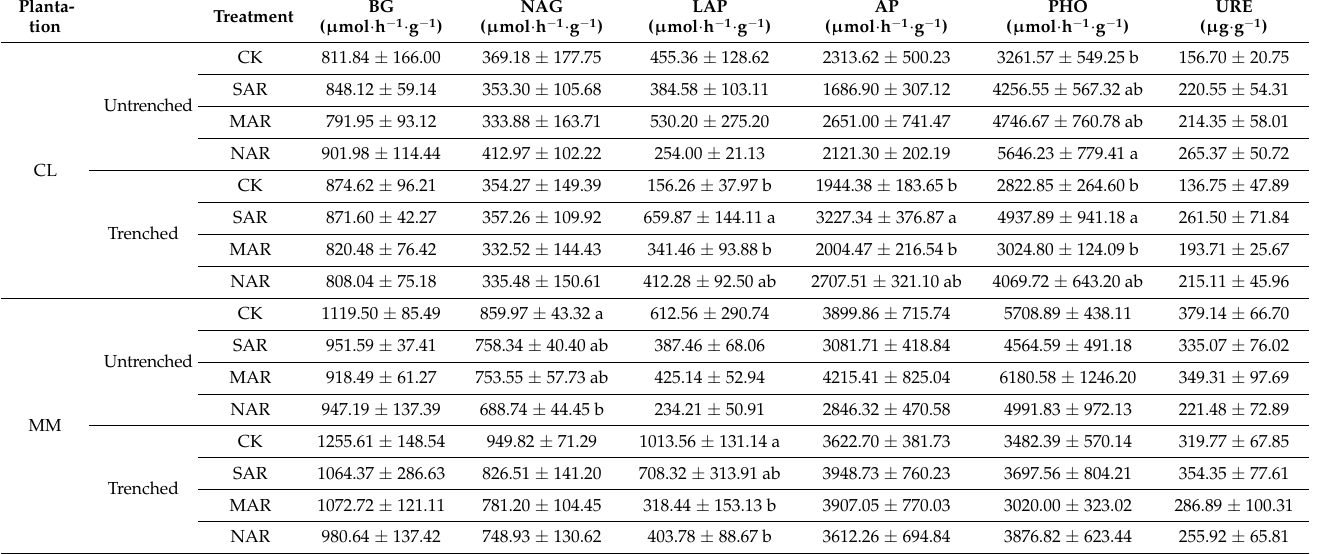
Table 4. Variations in soil enzyme activities under different types of acid rain in Cunninghamia lanceolata (Lamb.) Hook. (CL) and Michelia macclurei Dandy (MM) plantations. Data are the mean ± standard error ( n = 4). Means with different letters in common are significantly different ( p < 0.05). The absence of letters indicates no significant differences among acid rain